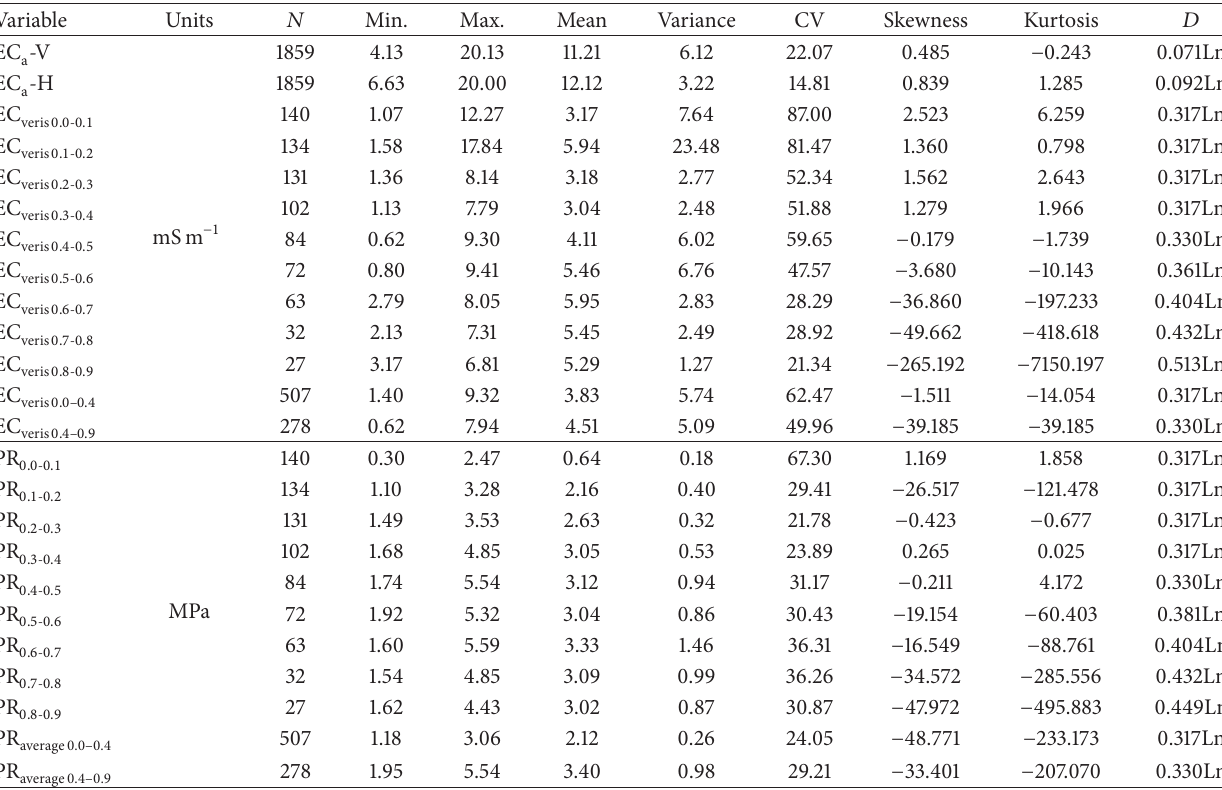
Table 1: Statistical parameters of the apparent electrical conductivity (EC a ) measured with EM38, in vertical and horizontal modes, and